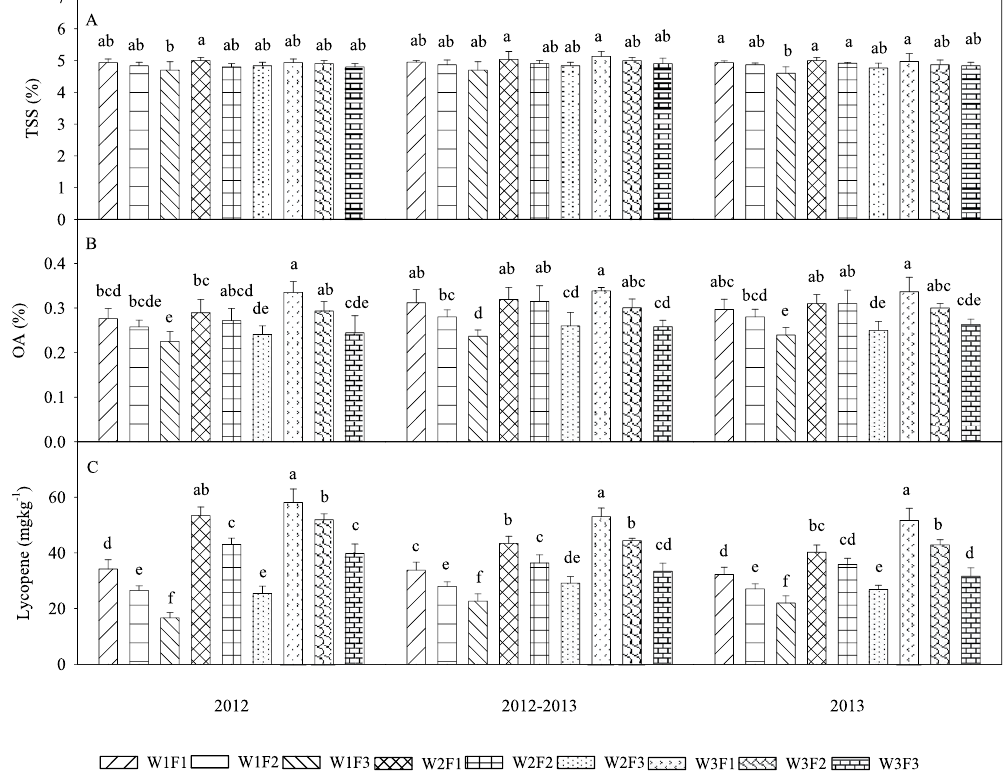
Figure 2. Effects of different irrigation and fertilization treatments on total soluble solids (TSSs) ( A ), the organic acid (OA) content ( B ) and the lycopene content ( C ) in fruit in three consecutive growing seasons in 2012 − 2013. Columns with the same letter represent values that are not significantly different at the 0.05 level of probability according to the LSD test. Each value is the mean ± SD (n = 3). The treatments are noted as W1, 100% ET 0 ; W2, 75% ET 0 ; W3, 50% ET 0 ; F1, N240 − P 2 O 5 120 − K 2 O150 kg ha − 1 ; F2, N180 − P 2 O 5 90 − K 2 O112.5 kg ha − 1 ; and F3, N120 −